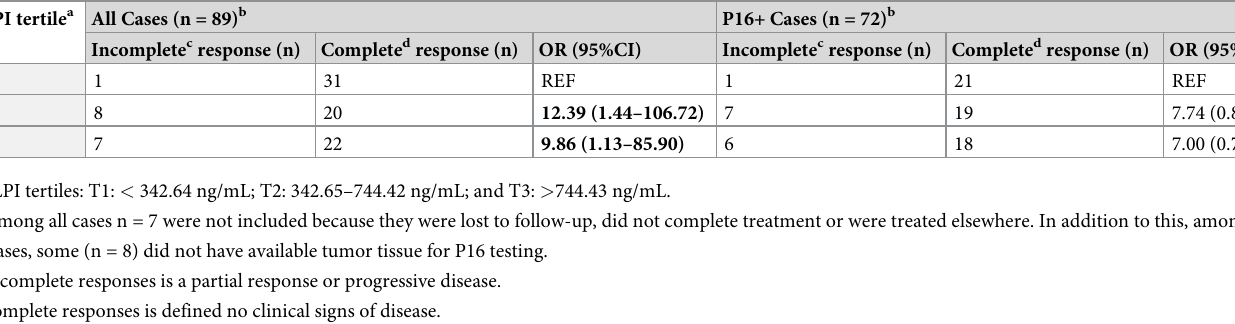
Table 4. Association of oral SLPI with risk of incomplete response to therapy at 3 months post-treatment evaluation among OPC cases and P16+ OPC cases. SLPI tertile a All Cases (n = 89) b